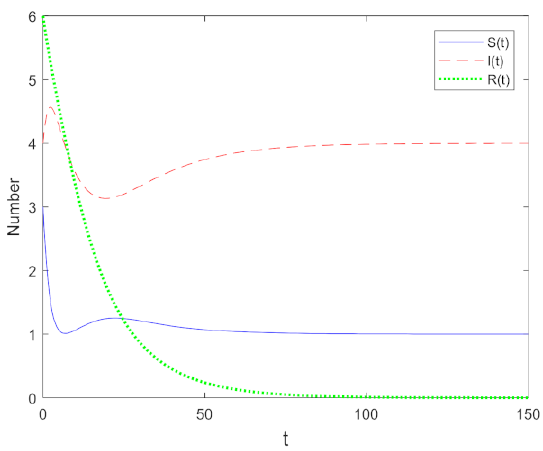
Figure 3. The stability of the equilibrium point E 3 . By taking parameters k = 0.4, β = 0.3, α = 0.001, λ = 0.1, µ = 0.15, we establish